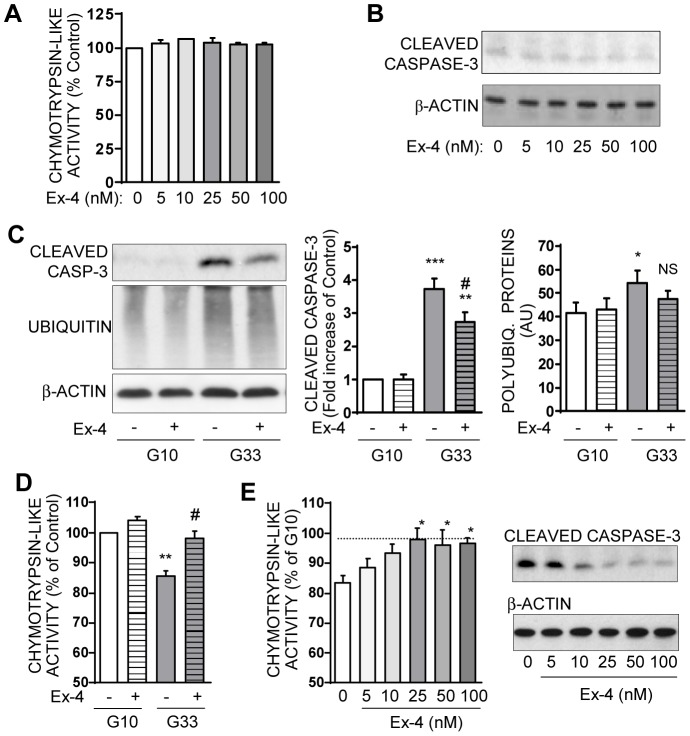
Exendin-4 partially prevents chronic high glucose-induced apoptosis and proteasome dysfunction in INS-1E cells.
A: INS-1E cells were cultured in 10 mM glucose medium for 48 hours with increasing concentrations (5–100 nM) of Exendin-4. Chymotrypsin-like activity was measured in cells lysates at the end of the treatment. Results are presented as means ± SEM of 3 independent experiments and expressed in percentage of the value without Exendin-4. B: Protein levels of cleaved caspase-3 levels and actin were analyzed by Western blotting in INS-1E cells cultured in 10 mM glucose medium for 48 hours with increasing concentrations (5–100 nM) of Exendin-4. Immunoblots presented are representatives of 3 independent experiments. C: Levels of cleaved caspase-3, polyubiquitinated proteins, and actin were analyzed by Western blotting in cells treated for 48 hours with 25 nM Exendin-4 in 10 mM (G10) or 33 mM glucose (G33) medium. Immunoblots presented are representative of 6 independent experiments. Quantitative analysis of bands density normalized to actin from these 6 independent experiments is also shown. Results are presented as means ± SEM and expressed as fold increase compared to the G10 value without Exendin-4. *P<0.05; **P<0.01, ***P<0.001 vs. G10; #P<0.05 vs. G33. D: Chymotrypsin-like activity was measured in lysates from INS-1E cells treated for 48 hours with 25 nM Exendin-4 in 10 mM (G10) or 33 mM glucose (G33) medium. Results are presented as means ± SEM of 3 independent experiments and expressed as the percentage of the G10 value. **P<0.01 vs. G10; #P<0.05 vs. G33. E: Chymotrypsin-like activity was measured in cells cultured for 48 hours in 33 mM glucose medium and with increasing concentrations of Exendin-4 (5–100 nM). Protein levels of cleaved caspase-3 and actin were analyzed by Western blotting. Immunoblots presented are representatives of 3 independent experiments. *P<0.05 vs G33 without Exendin-4.